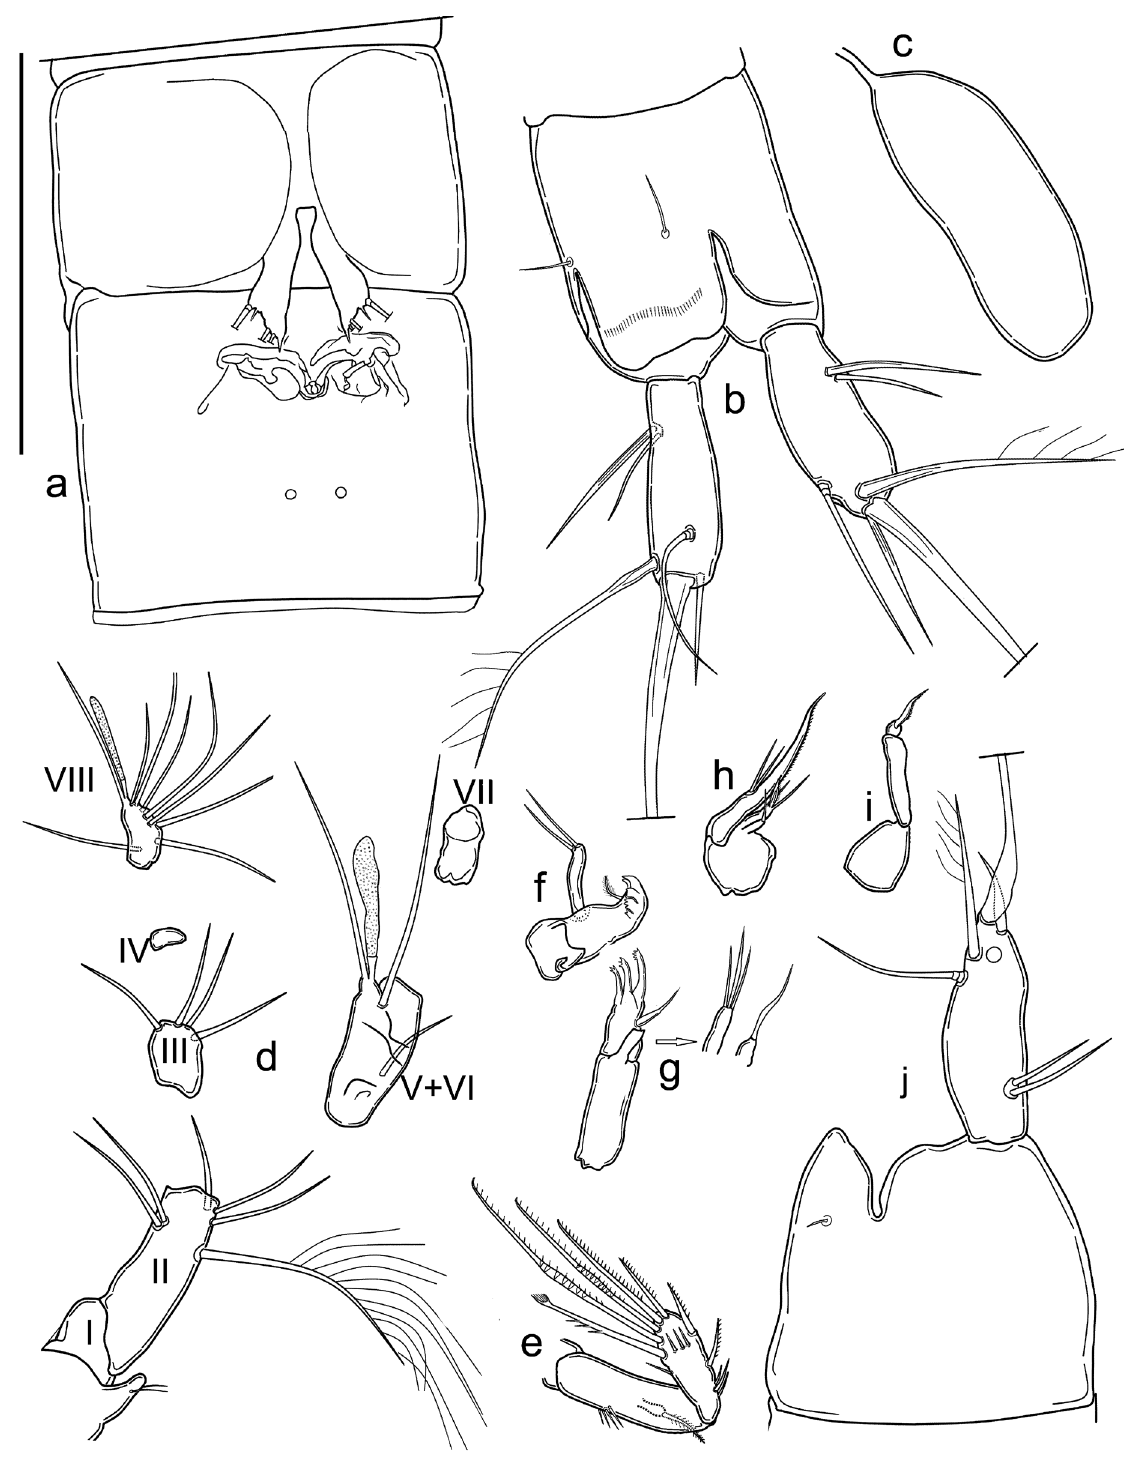
Fig. 12. a . Stammericaris vincentimariae Bruno & Cottarelli sp. nov., ♀ (NHMUK), first urosomite, P5, P6, genital double-somite and genital field, ventral view. — b–j . Proserpinicaris specincola Bruno & Cottarelli sp. nov., ♂ (NHMUK). b . Anal somite, anal operculum and caudal rami, dorsal view. c . Spermatophore. d . Rostrum and A1, disarticulated (antennular segments marked with roman numerals). e . A2. f . Mdb. g . Mx1. h . Mx2. i . Mxp. j . Anal somite, anal operculum and caudal rami, lateral view. Scale bar: 50